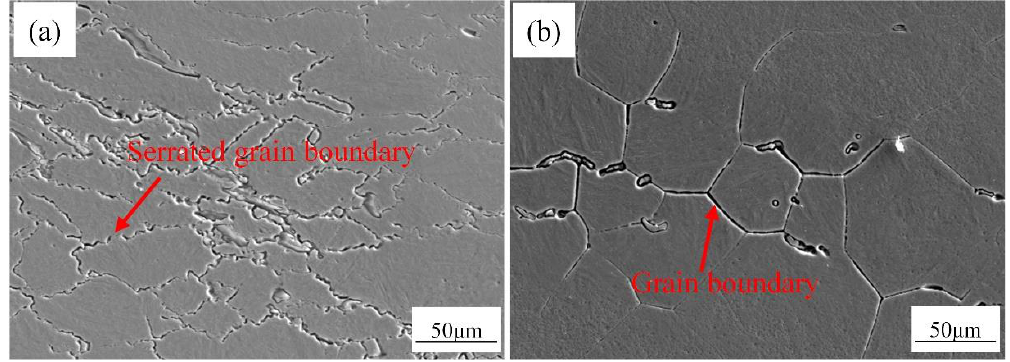
Figure. 9. Grain morphologies under different deformation conditions: ( a ) 950 °C, 1s –1 ; (b) 1050 °C, 1s – Figure 9. Grain morphologies under different deformation conditions: ( a ) 950 ◦ C, 1 s − 1 ; ( b ) 1050 ◦ C, 1 s − 1 1 .